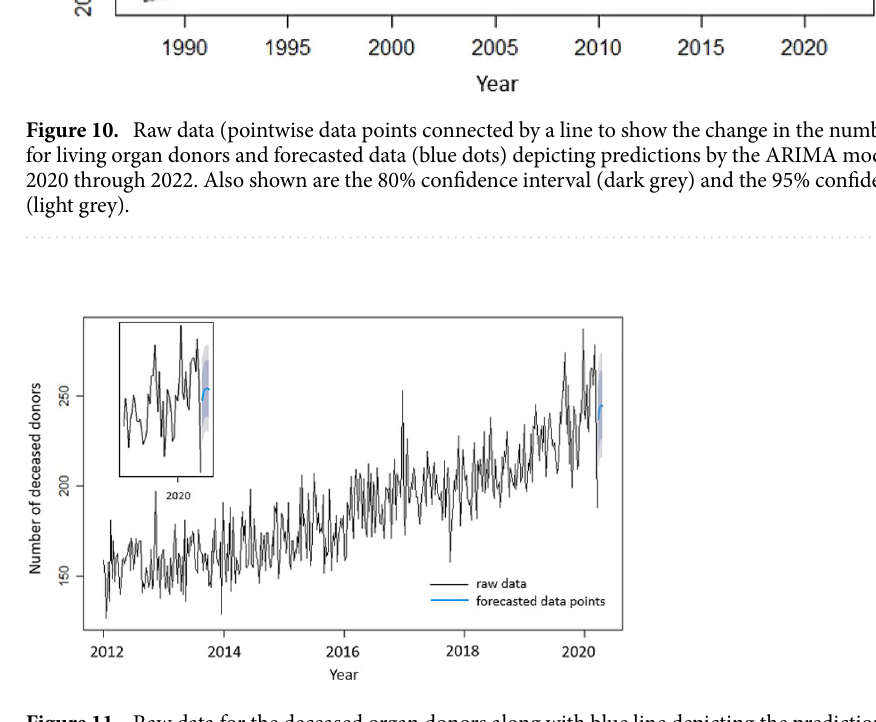
Figure 11. Raw data for the deceased organ donors along with blue line depicting the predictions by M1 ARIMA(0,1,2)(1,0,0) with drift. Also shown are the 80% confidence interval (dark grey) and the 95% confidence interval (light grey). The figure inset on the top left corner is a zoomed in view of the forecasted points and the confidence